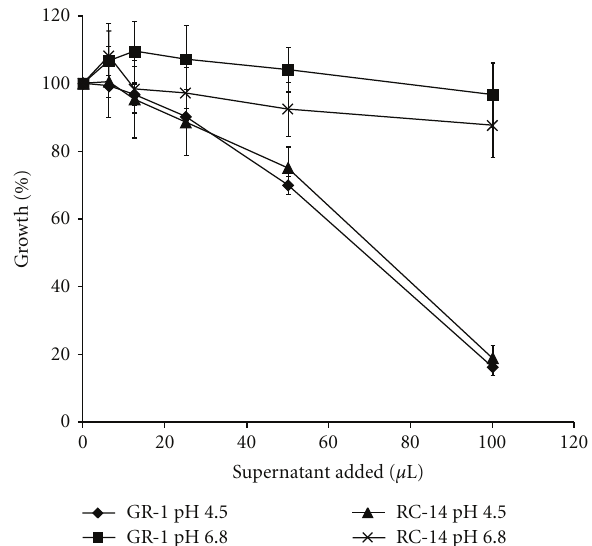
Figure 3: Growth inhibition of C. albicans by culture supernatants from probiotic lactobacilli. Cell-free culture supernatants of L. rhamnosus GR-1 and L. reuteri RC-14 were collected after 48 hrs of growth and adjusted to pH 4.5 and pH 6.8 using sodium hydroxide. Varying amounts of the supernatants were added to MRS media inoculated with C. albicans in microtiter plates (total volume per well 200 µ L). After incubation at 37 ◦ C for 24 hrs, the cell densities were determined by OD 600nm readings. The inhibitory e ff ect of the supernatants at low pH was lost at pH 6.8. Error bars show the standard deviations of at least triplicate